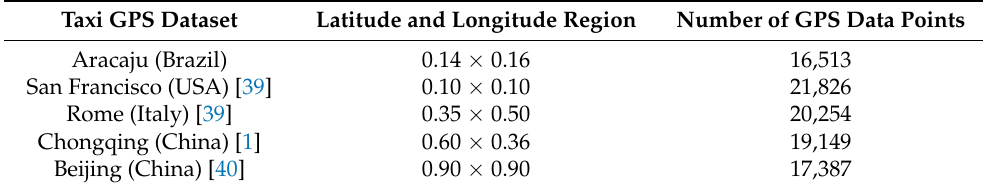
Table 1. Taxi GPS datasets. Taxi GPS